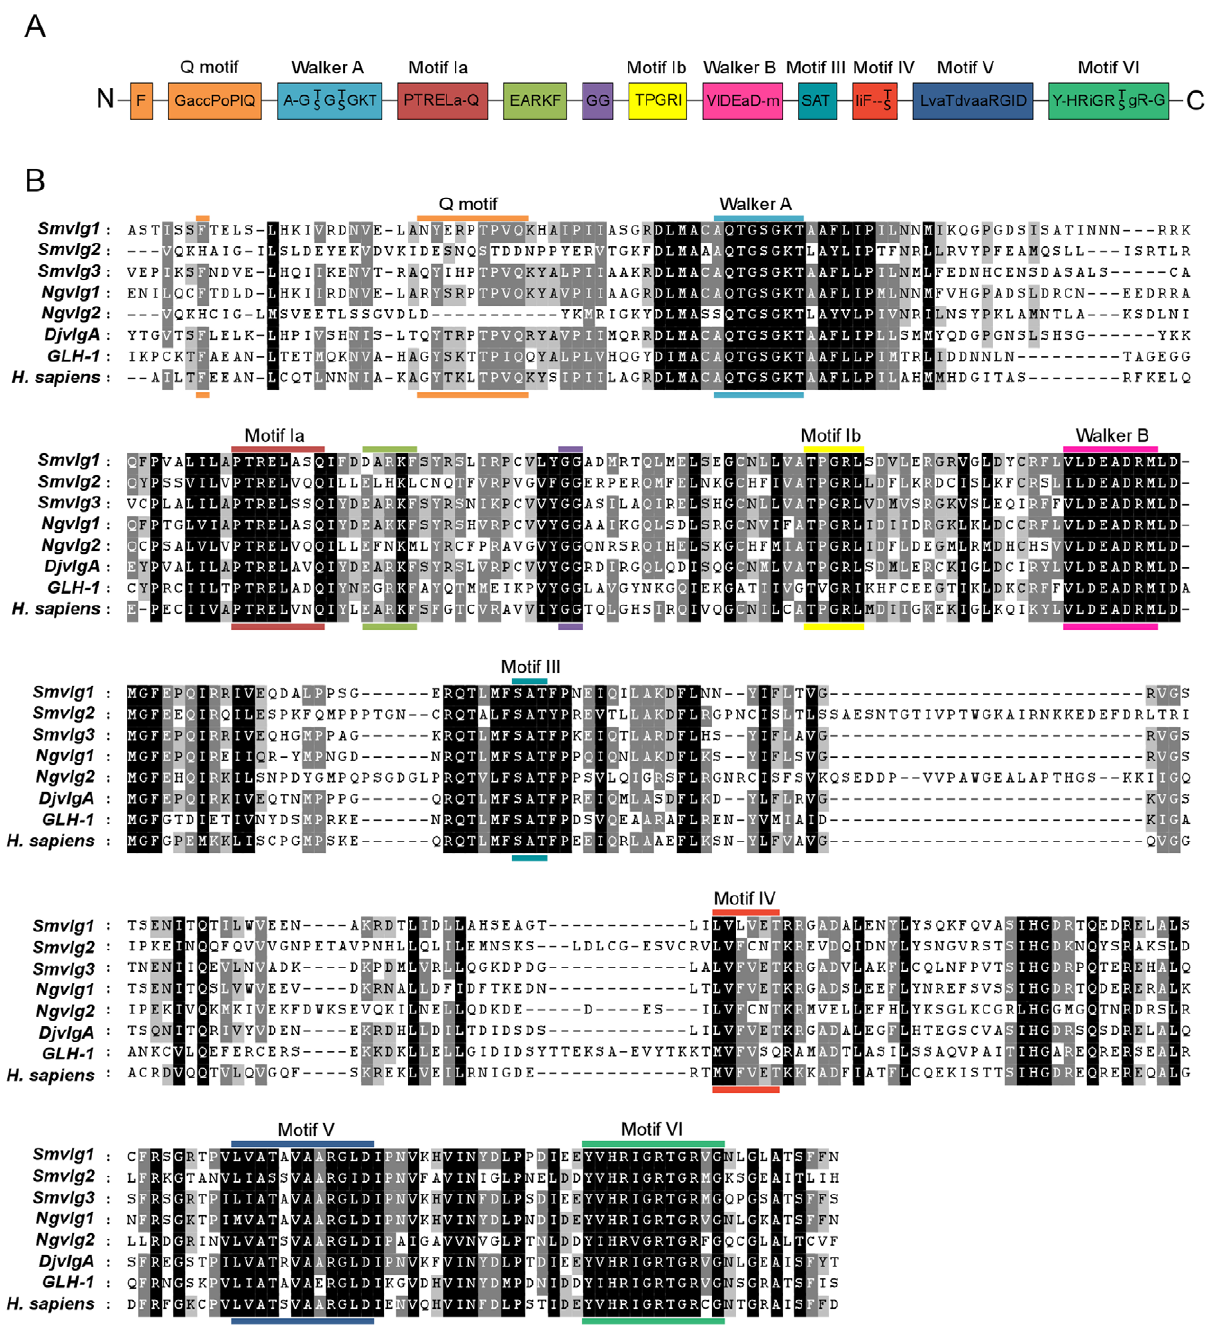
Figure 1. Multiple sequence alignment of DEAD-box RNA helicases from Schistosomamansoni . Panel A: Schematic representation of ten motifs conserved in DEAD-box helicases; the EARKF motif, also shown, is conserved in Vasa and PL10 DEAD-box helicases. For each motif, with the exception of the Q motif, the capital case letters in the consensus sequence indicate highly conserved amino acids (in . 80% enzymes) whereas lower case letters represent amino acids conserved in 50–79% of helicases [49]. The capital case letters of the Q motif indicate amino acids conserved between 49%–99% of helicases. The lower case letters represent groups of amino acids, where a represents an aromatic residue, c is a charged residue, o is an alcohol, and l is an aliphatic residue [48]. Panel B: Multiple sequence alignment of DEAD-box RNA helicases from Schistosoma mansoni , informative Vasa-like enzymes from other flatworms, Caenorhabditis elegans and Homo sapiens . DEAD box motifs are indicated with colored lines above and below the sequence that corresponds with the colors in the schematic representation (panel A). Accession numbers of aligned orthologues: Smvlg1 of Schistosoma mansoni (JQ619869), Smvlg2 of S. mansoni (JQ619870), Smvlg3 of S. mansoni (a consensus of Smp_068440 and JQ619871), Ngvlg1 of Neobenedenia girellae (BAF44659), Ngvlg2 of N. girellae (BAF44660), DjvlgA of Dugesia japonica (BAA34993), GLH-1 of Caenorhabditis elegans (P34689.3), and Vasa of Homo sapiens (AAF72705).